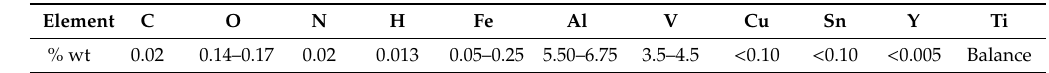
Table 2. Chemical composition of